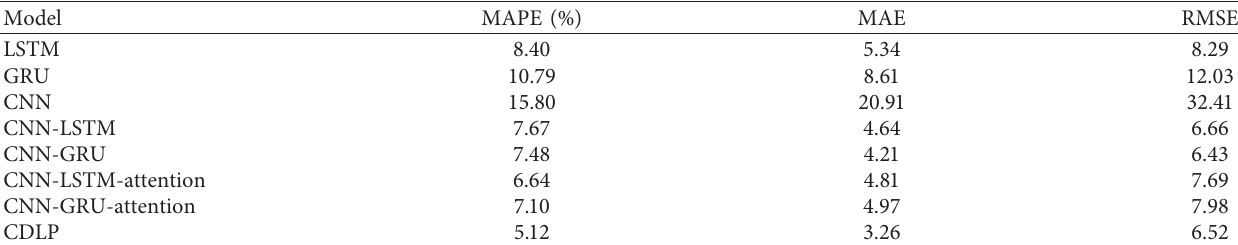
Figure 8: Error comparison of CDLP, CNN-LSTM-attention, and CNN-GRU-attention: (a) error of the first week in test set; (b) error of the second week in the test set. Table 4: Comparison of three evaluation indexes of CDLP and baseline models.